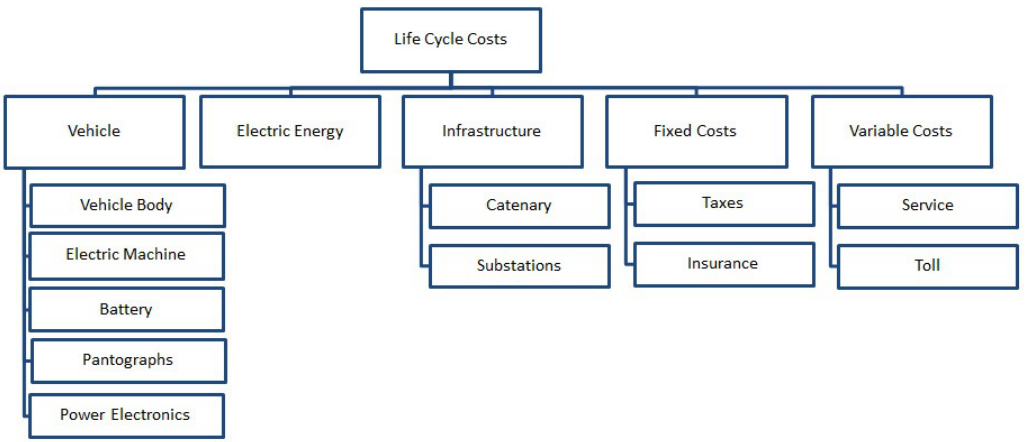
Figure 5. Composition of life cycle costs for an overhead catenary truck.